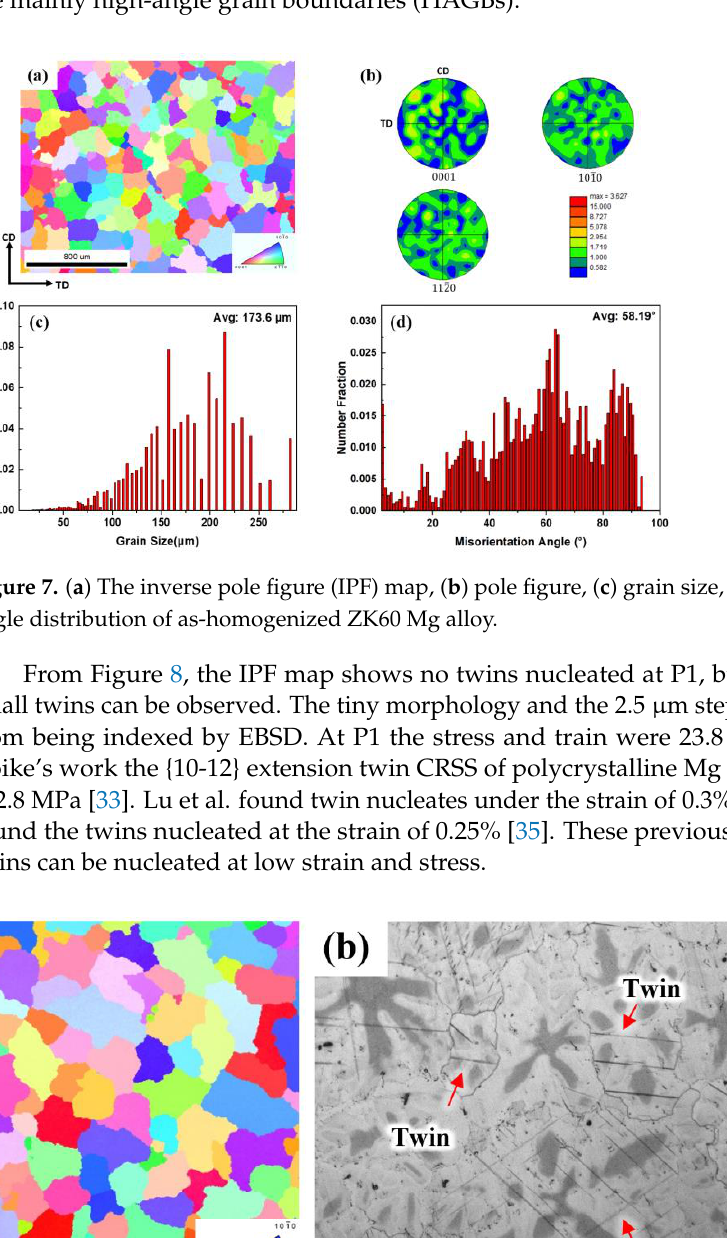
Figure 6. The true stress-strain curve and strain hardening rate-true strain curve.